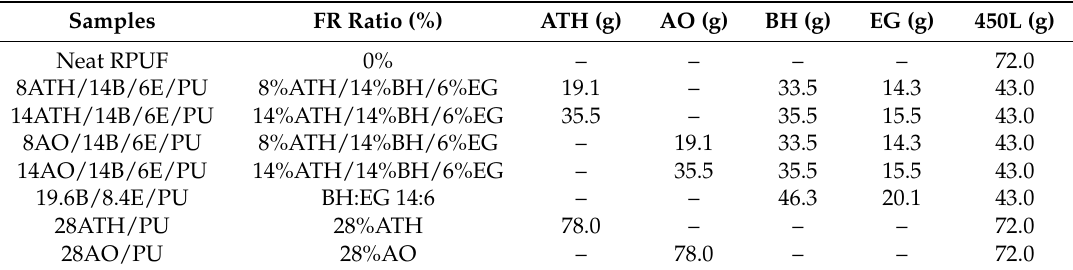
Table 1. Formulae of flame retardant rigid polyurethane foams (RPUFs) a